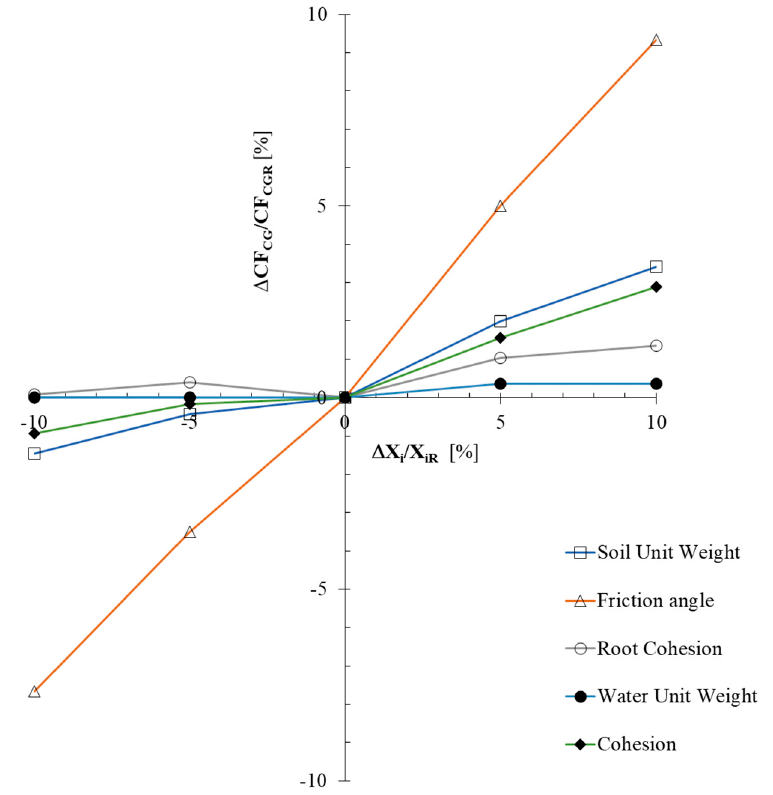
Figure 10. Sensitivity analysis for the five input parameters.